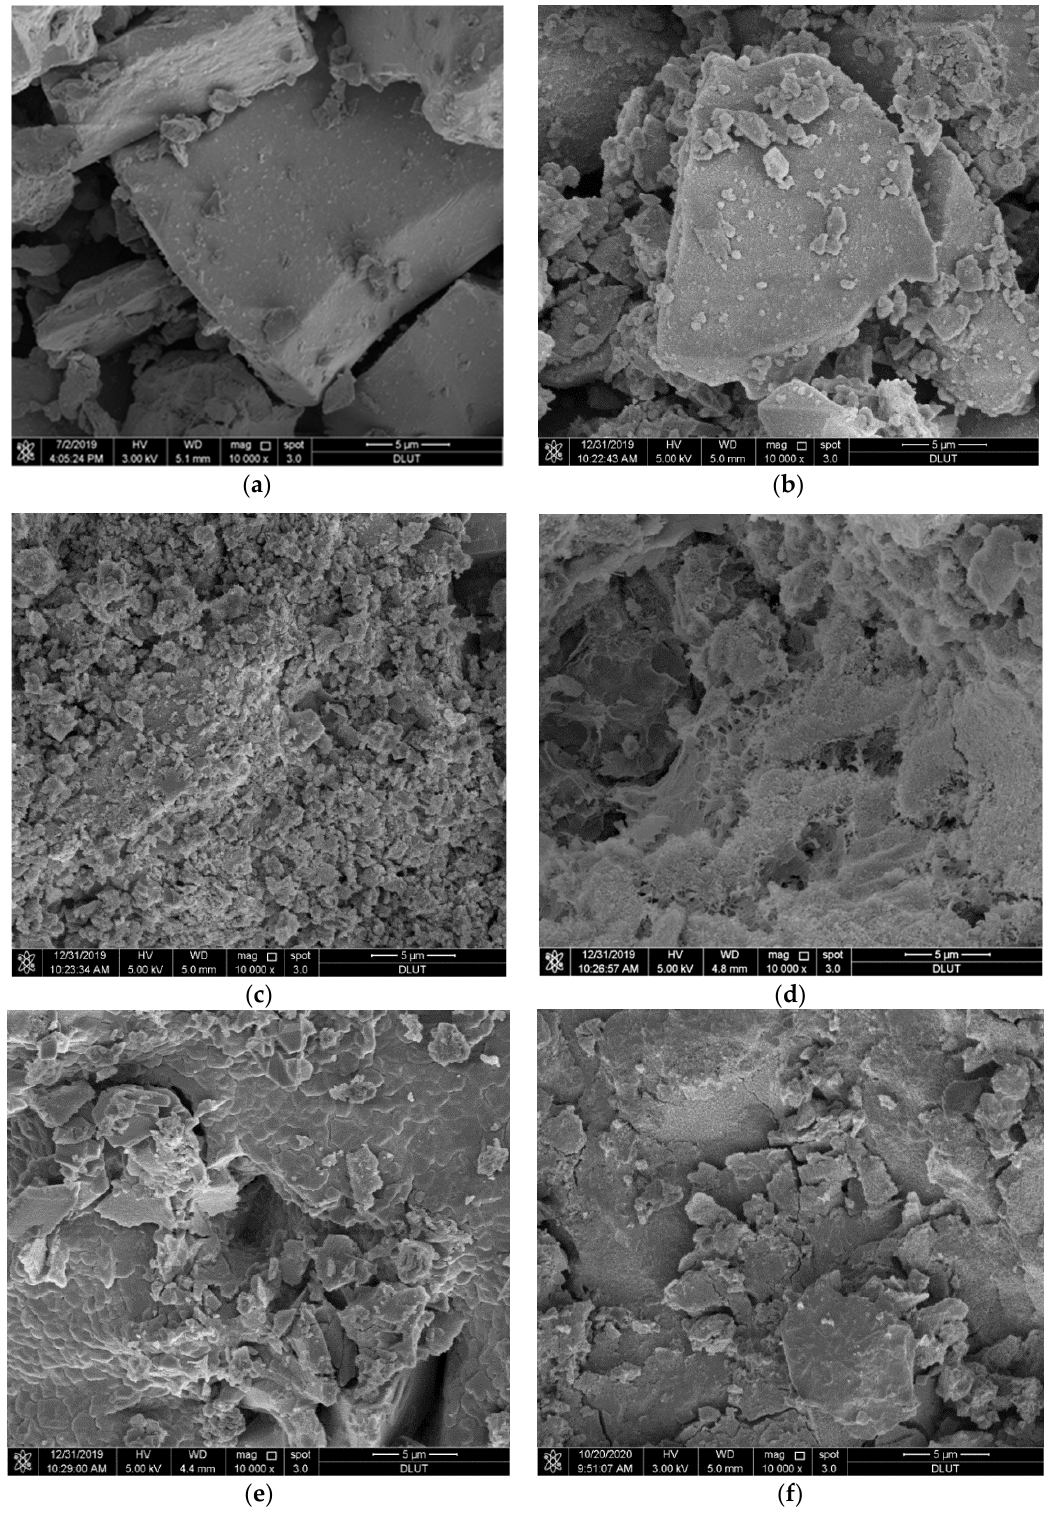
Figure 12. SEM images of the hydration products of CNS with different sodium silicate contents: ( a ) raw material (CNS), ( b ) C1, ( c ) C2, ( d ) C3, ( e ) C4, and ( f ) C5.